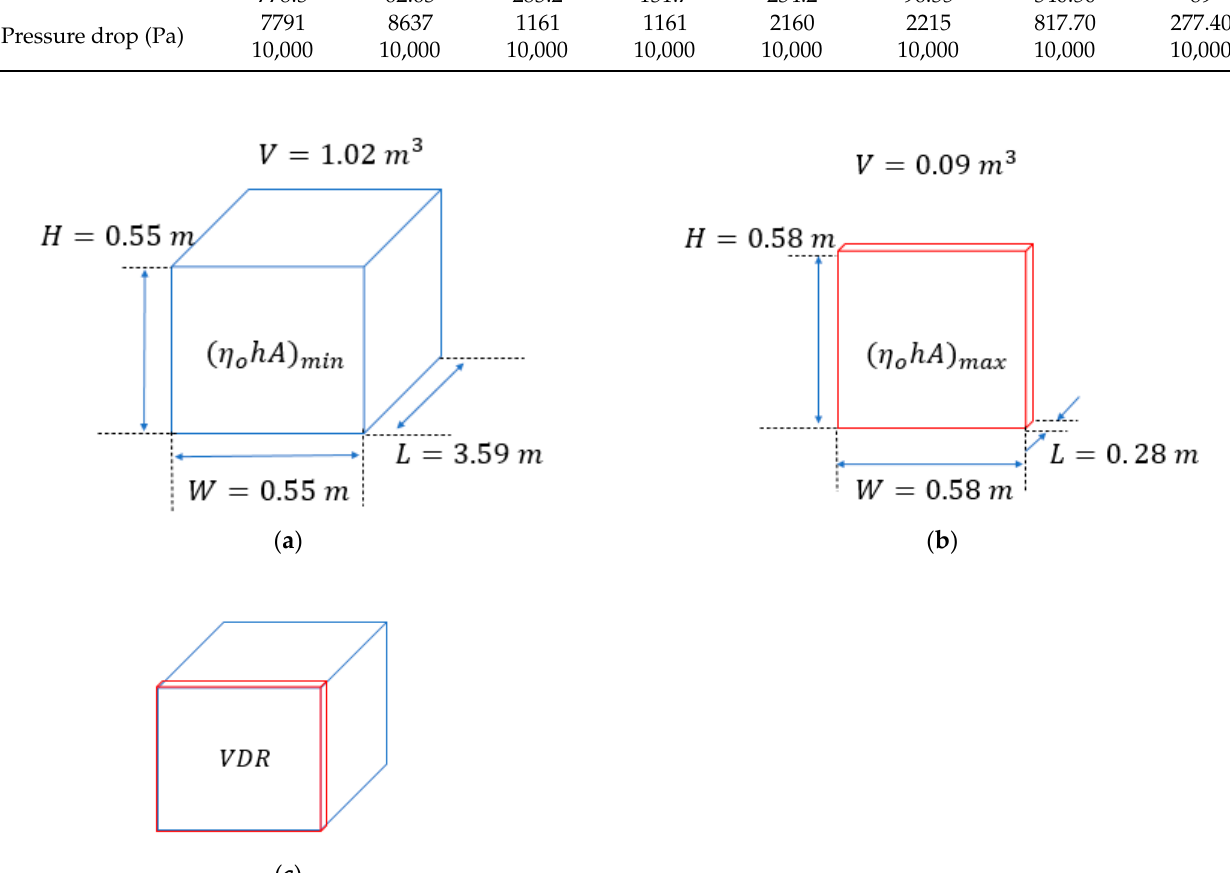
Figure 5. Volume design region for the case study using offset strip-fins. ( a ) Maximum volume, ( b ) minimum volume, ( c ) volume design region.